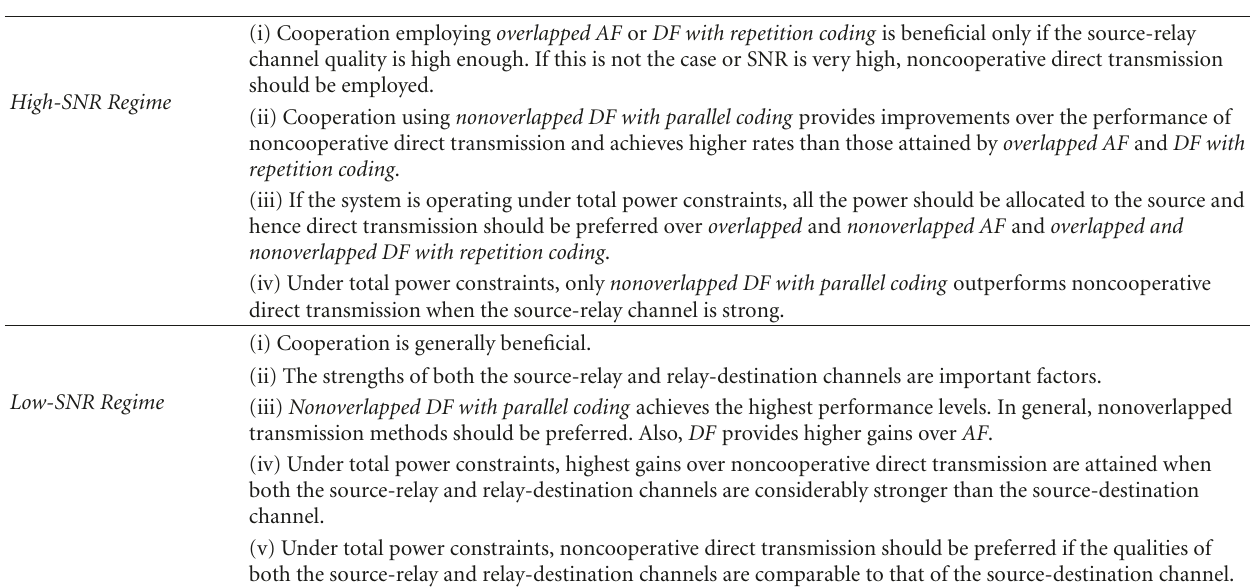
High-SNR Regime